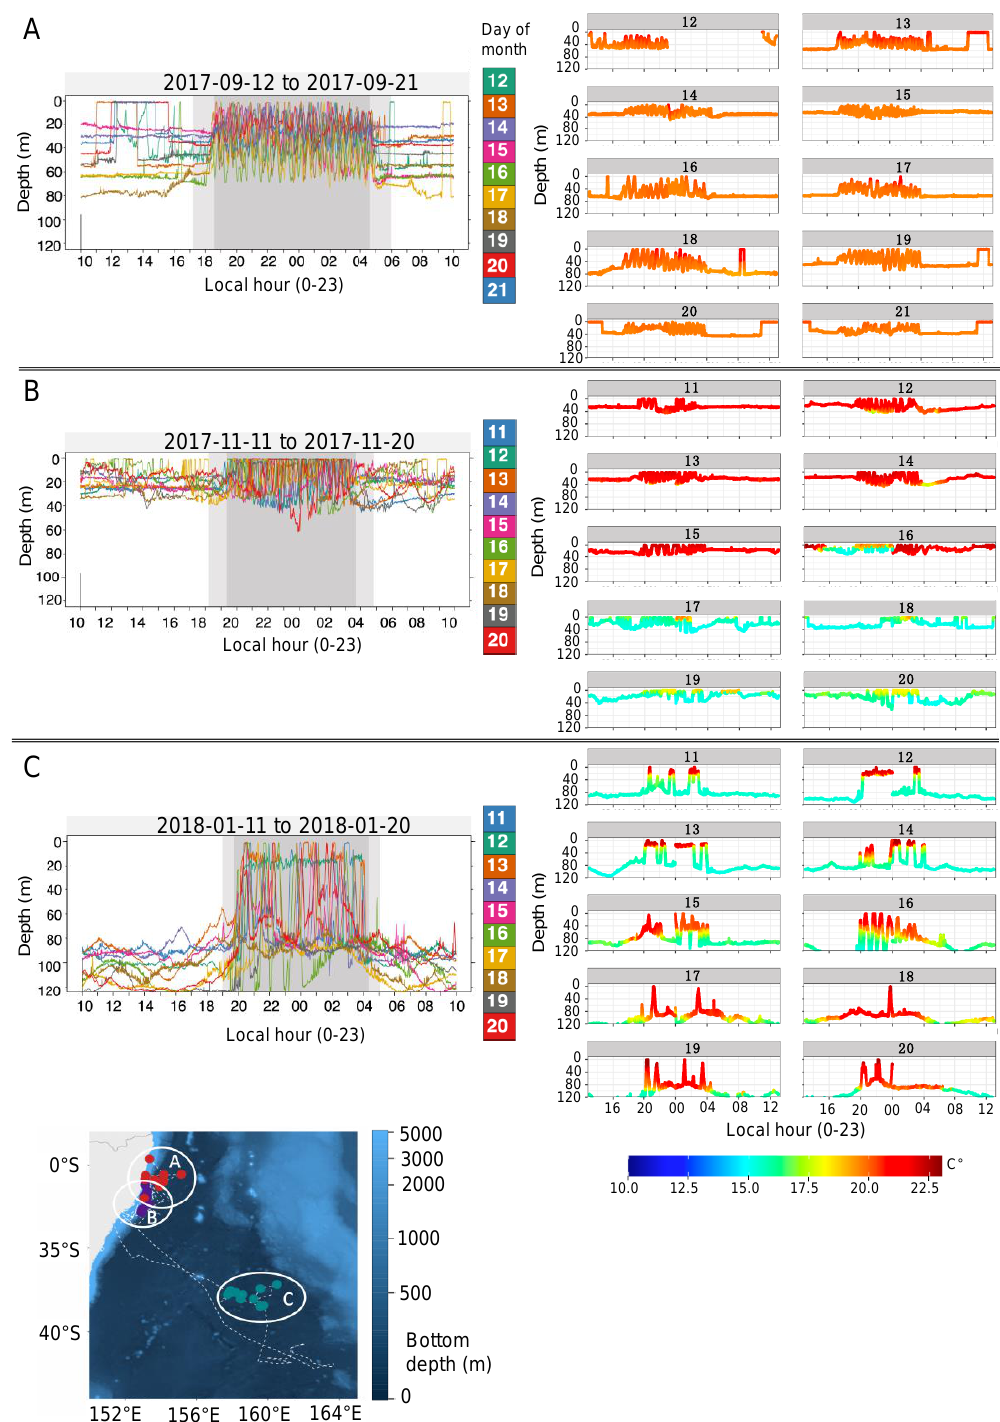
Figure 4. Fine–scale diving behaviour. Representative archival time-series depth and temperature data from shark 180 (210 cm FL, female). ( A – C ) Each plot on the left displays ten days of diving data collected at 3-s intervals and colour-coded by day. Areas shaded in grey indicate approximate night-time (darker grey) and twilight periods (lighter grey). ( A – C ) Plots on the right display the associated daily temperature records collected at 3-s intervals. Locations of track periods are indicated in the map. The map was generated using the marmap package in R [37]. Full archival time-series depth and temperature data for all four recovered archival tags are available in the supplement (Figure